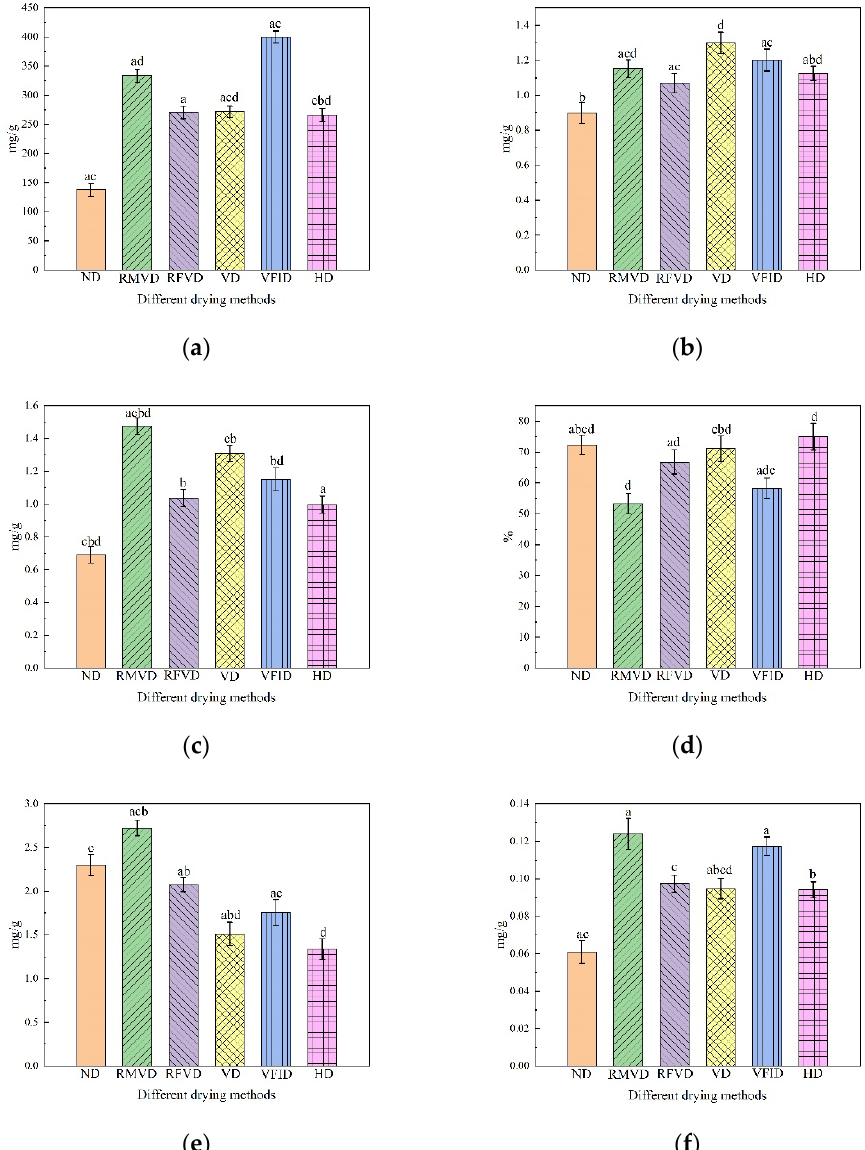
Figure 3. Polysaccharide content ( a ), total phenolic content ( b ), total flavonoid content ( c ), antioxidant properties ( d ), lobclyolin content ( e ), syringin ( f ) of Codonopsis pilosulae. Different letters represent significant differences ( p < 0.05). ND: natural drying; RMVD: rotary microwave vacuum drying; RFVD: radio frequency vacuum drying; VD: vacuum drying; VFID: vacuum far infrared drying.